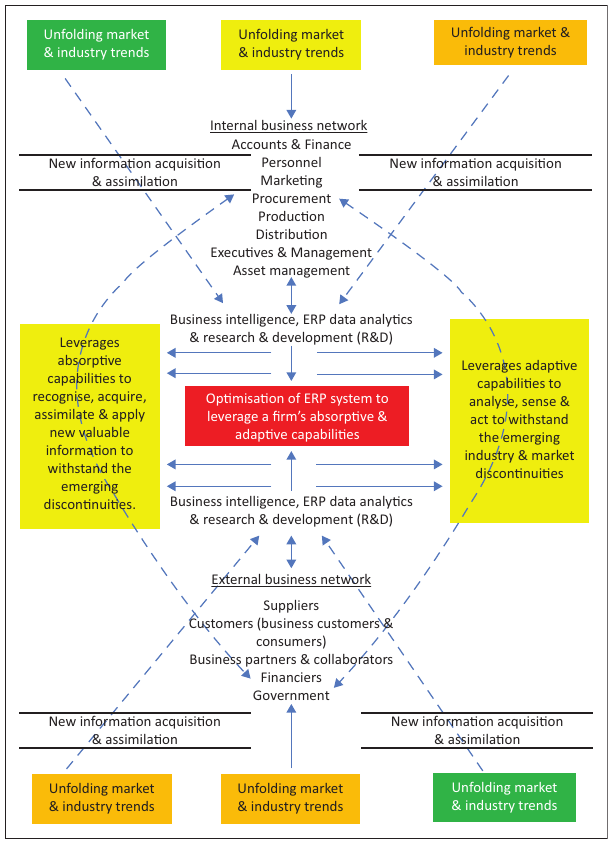
FIGURE 1: Optimising enterprise resource planning system to leverage a firm’s absorptive and adaptive